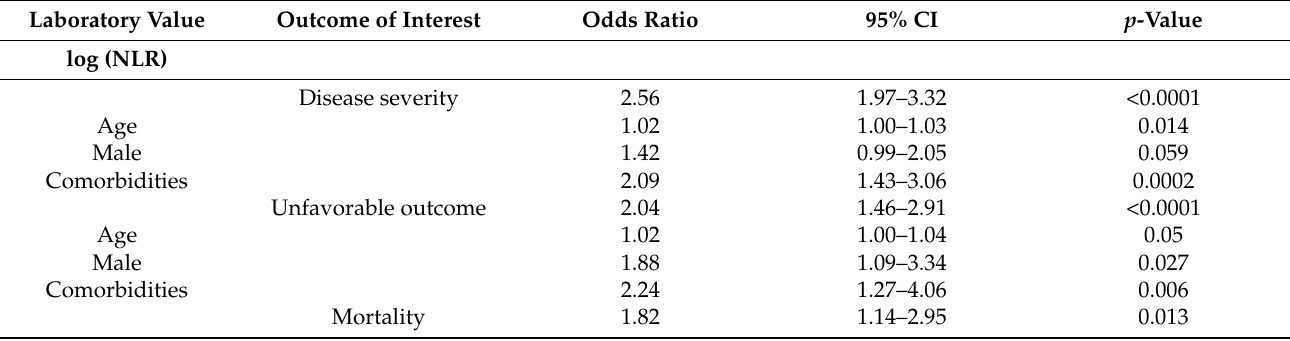
Table 3. Proportional odds logistic regression for disease severity and binary logistic regression analysis for unfavorable outcome and